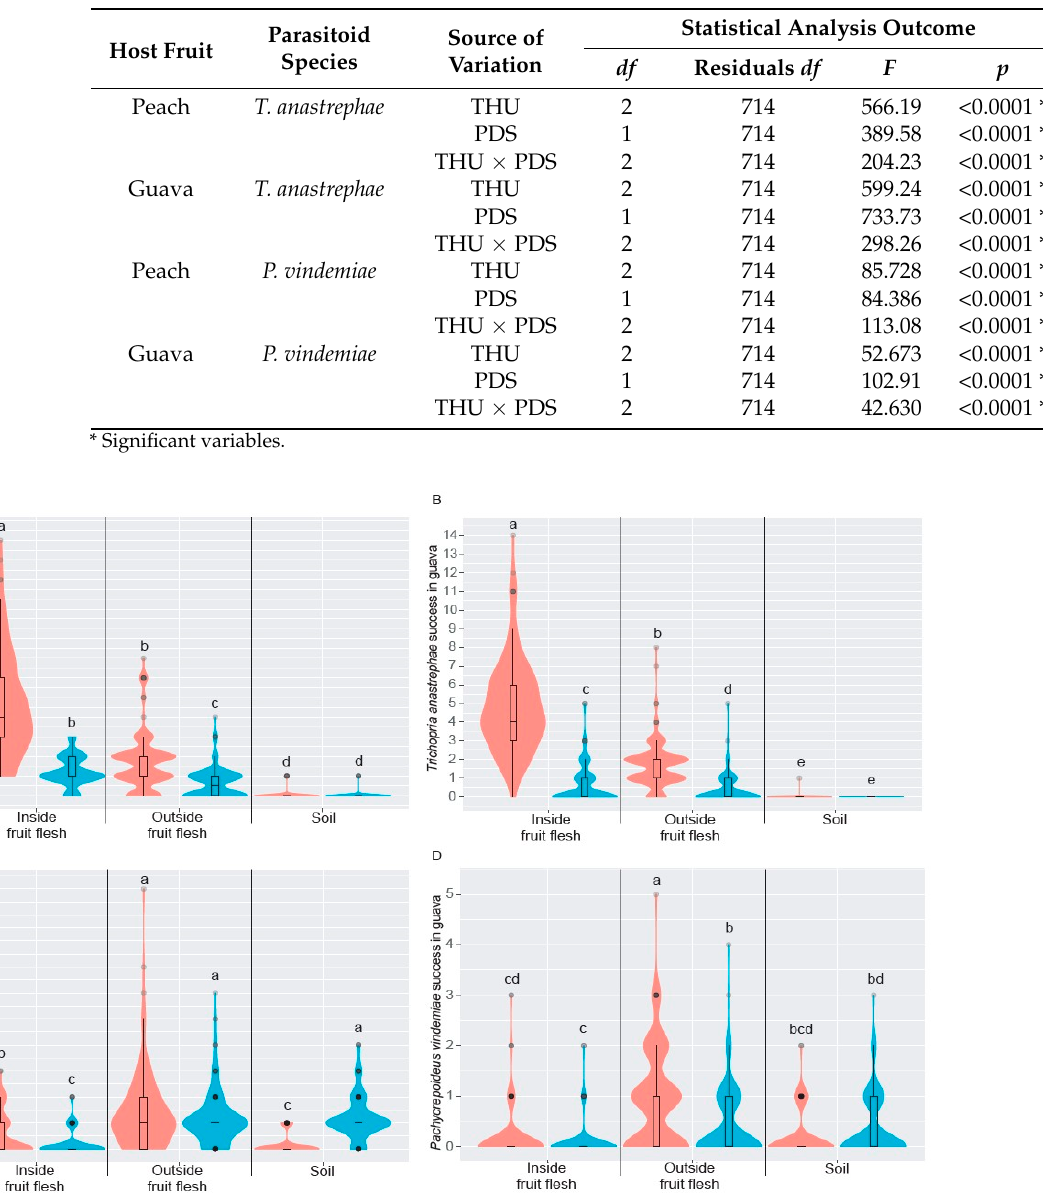
Table 2. Summary of Aligned Rank Transform ANOVA on the effect of the type of microhabitat used for host parasitism (=THU), the parasitized drosophilid species (=PDS), and their interaction on the adult emergence of both Trichopria anastrephae and Pachycrepoideus vindemiae , with data recorded from saprophytic Drosophila spp. and D. suzukii puparia recovered from peach and guava.